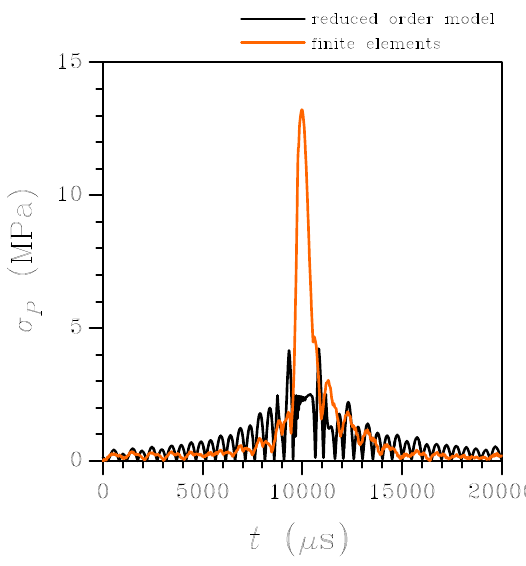
Figure 5. Low- g test: time evolution of the maximum principal stress in the plate-spring connection region. Comparison between FE and ROM